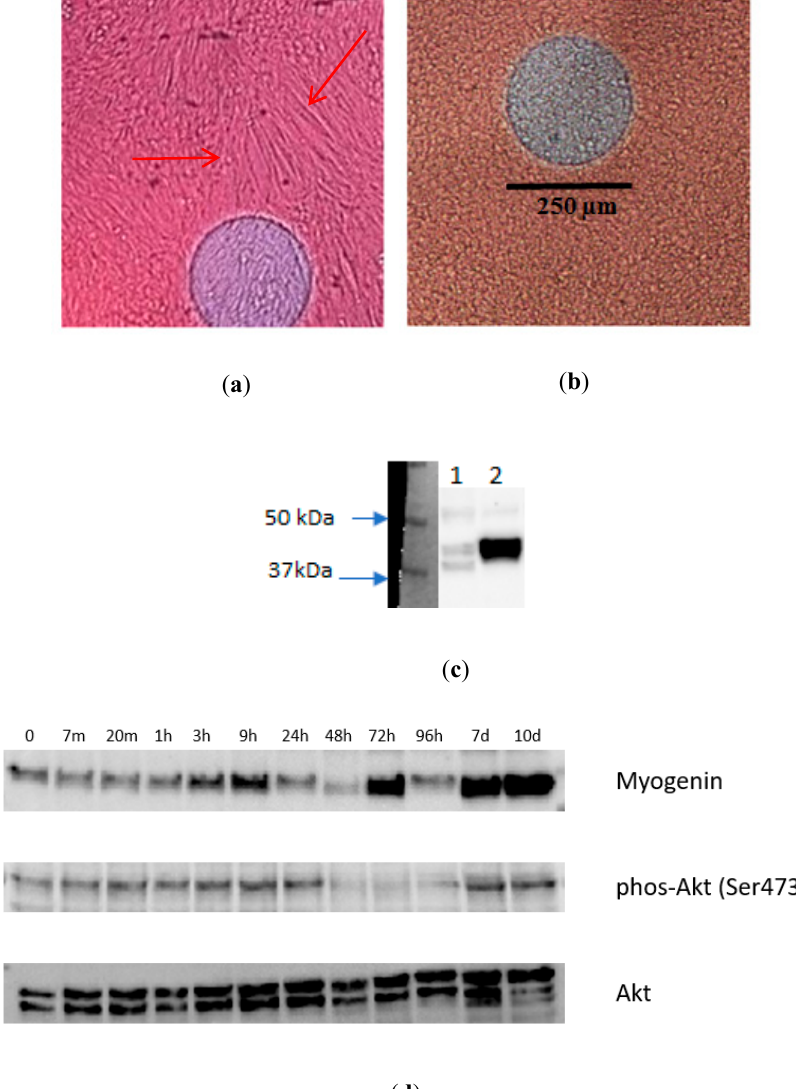
Figure 6. Evaluation of the cell cultures. ( a ) Microscope image of Well 6 (stem cells for differentiation) on the eighth day from the start of differentiation. Tubular structures corresponding to muscle myotubes can be observed (the arrows point at several of these structures). ( b ) Microscope image of Well 2 (stem cells without differentiation) on the eighth day from the start of differentiation in other wells. The difference between the cells that have started to differentiate and those that are not differentiating can be observed. ( c ) Level of expression of the anti-alpha smooth muscle actin antibody (ab5694, 42 kDa) in undifferentiated wells (column 1) and differentiated wells (column 2). The difference in the protein expression is in accordance with microscope images. ( d ) Level of expression of different muscle-specific proteins (Myogenin, Phos-Akt (Ser 473) and Akt) in differentiated cells, at different times during the experiment.